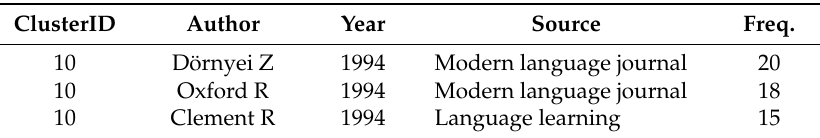
Table 12. The Members of Cluster #